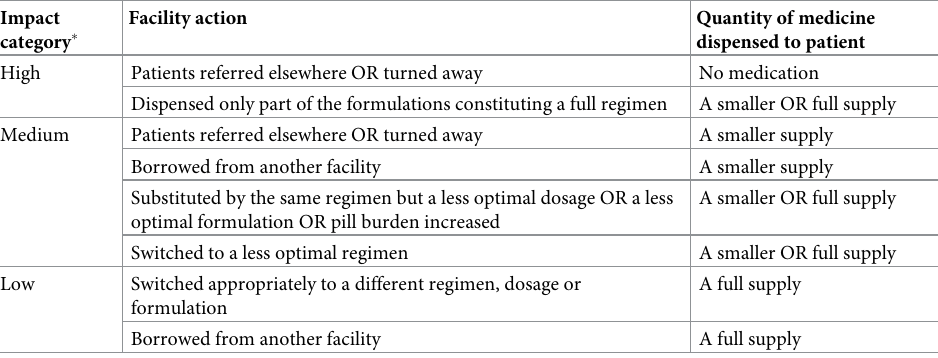
Table 2. Definitions of high, medium and low impact of